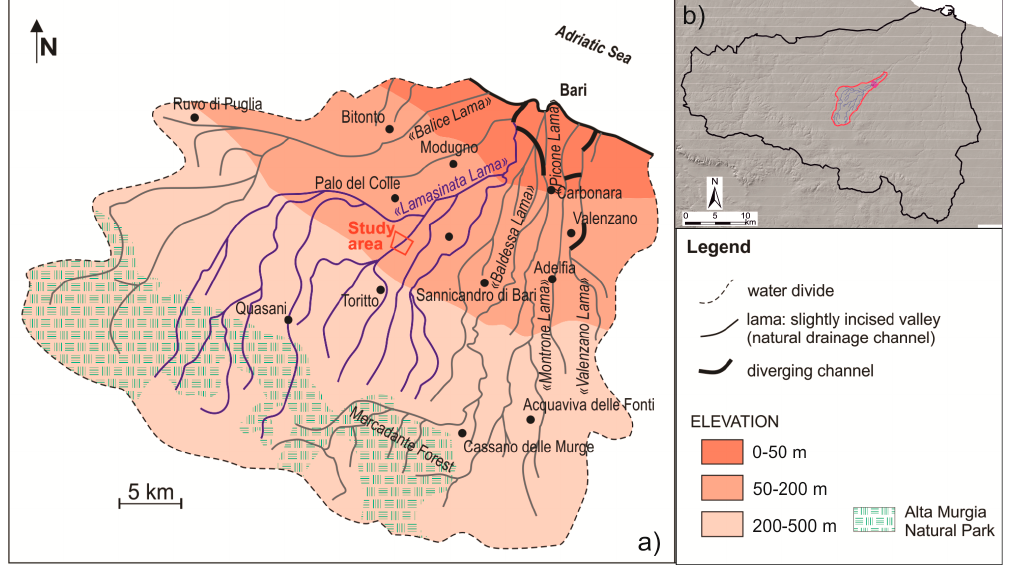
Figure 3. ( a ) Drainage network map of the catchment basin of Bari area (modified and redrawn after Reference [11]). ( b ) Hillshade map showing the Lama Lamasinata catchment (red line) and the local reach of the valley (filled purple box).